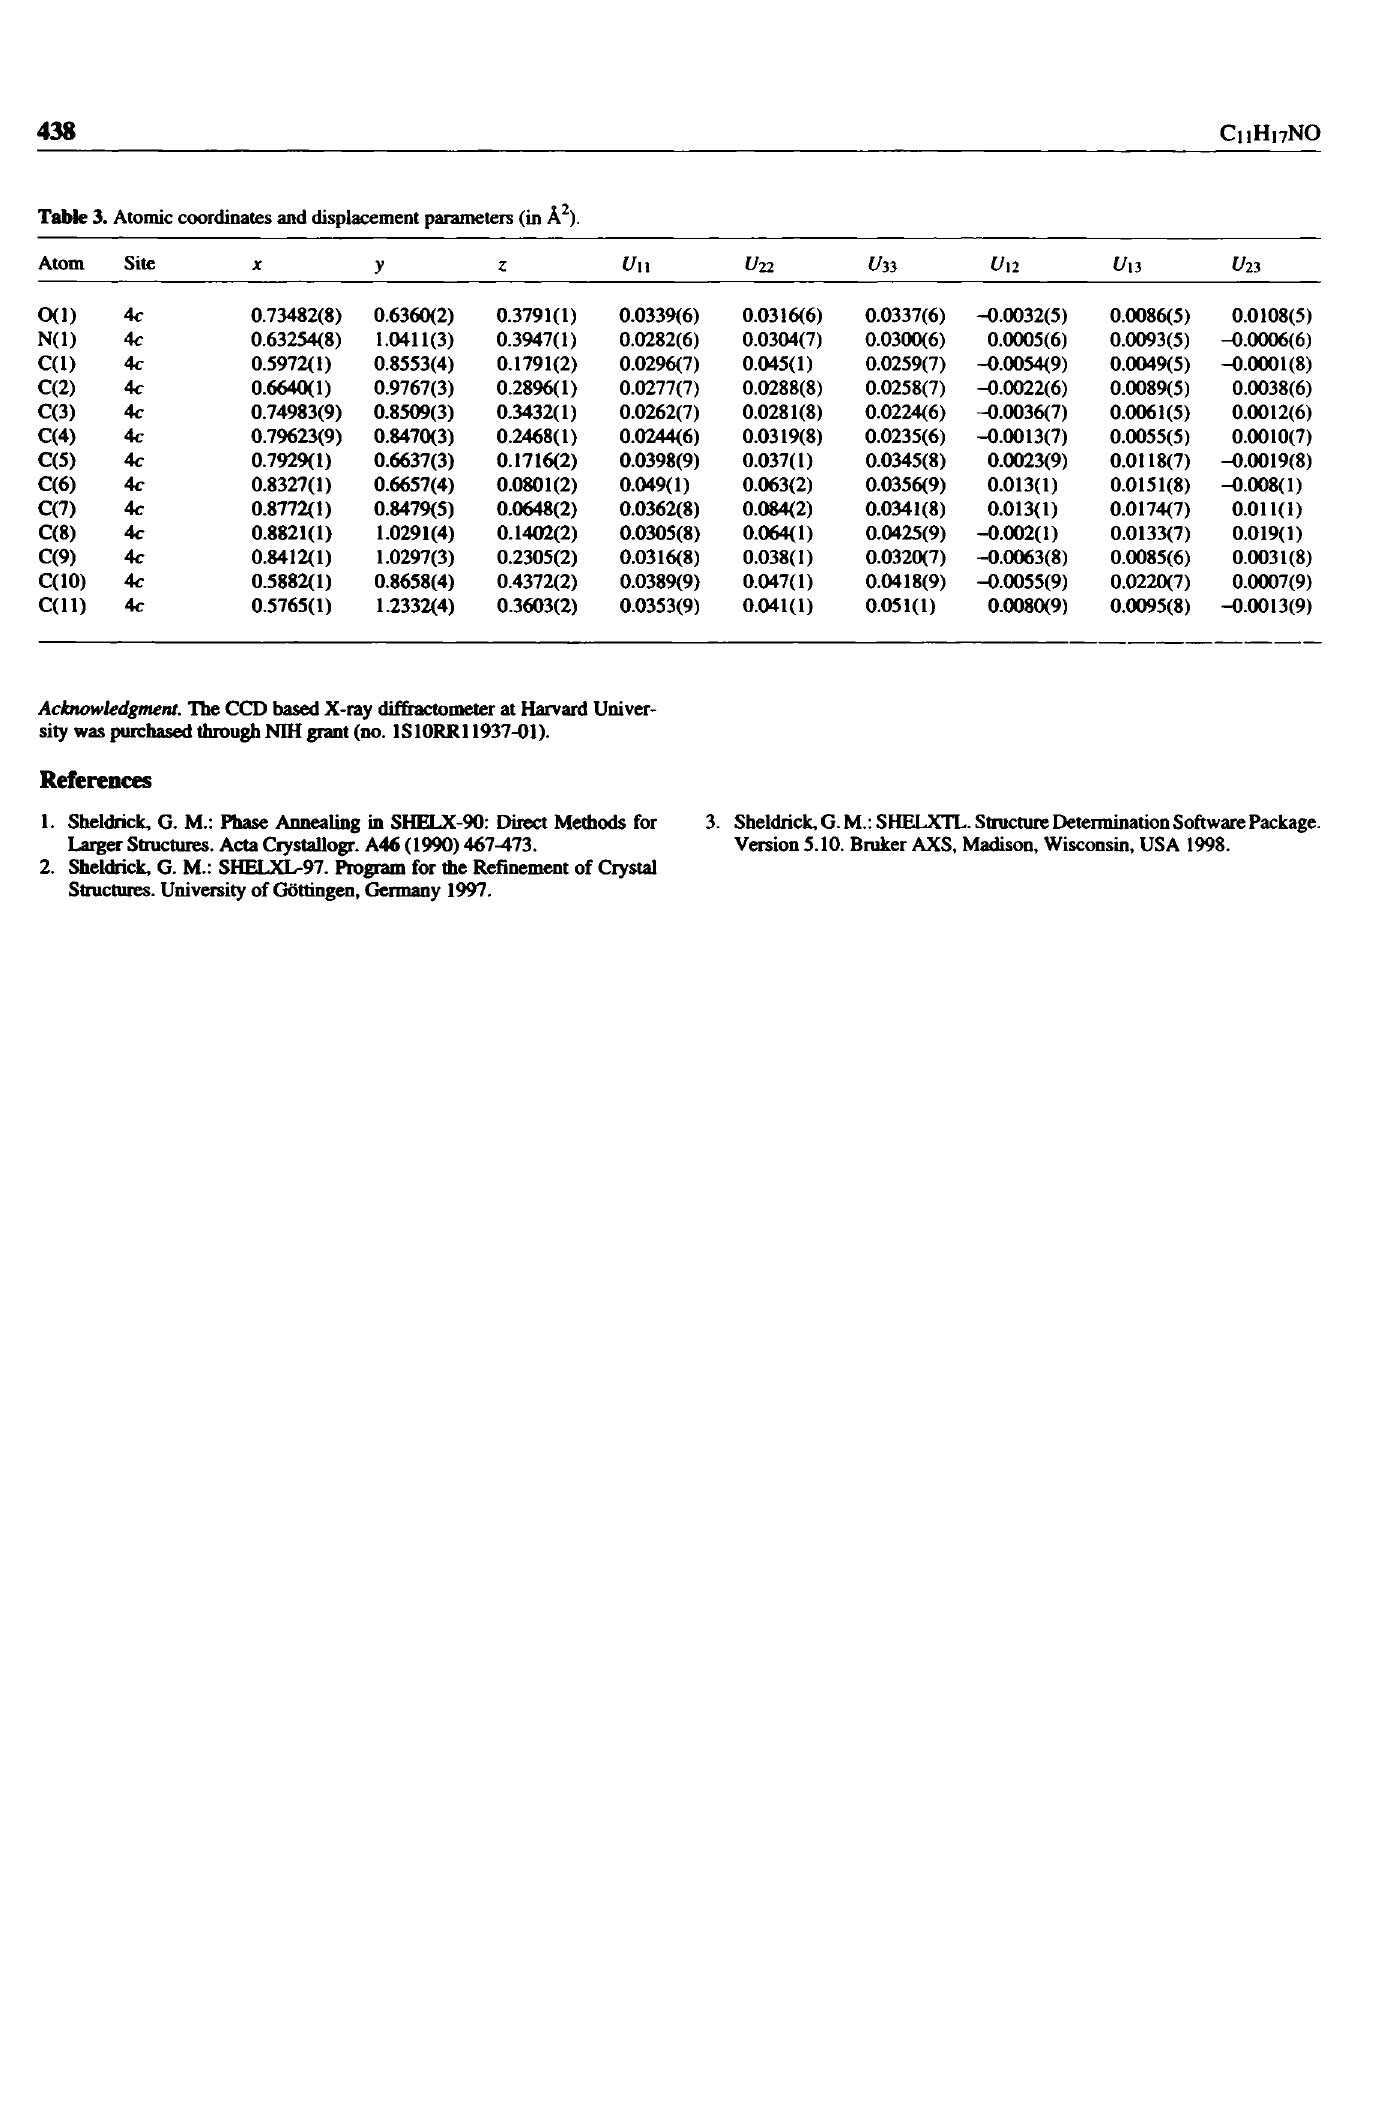
Table 3. Atomic coordinates and displacement parameters (in Ä 2